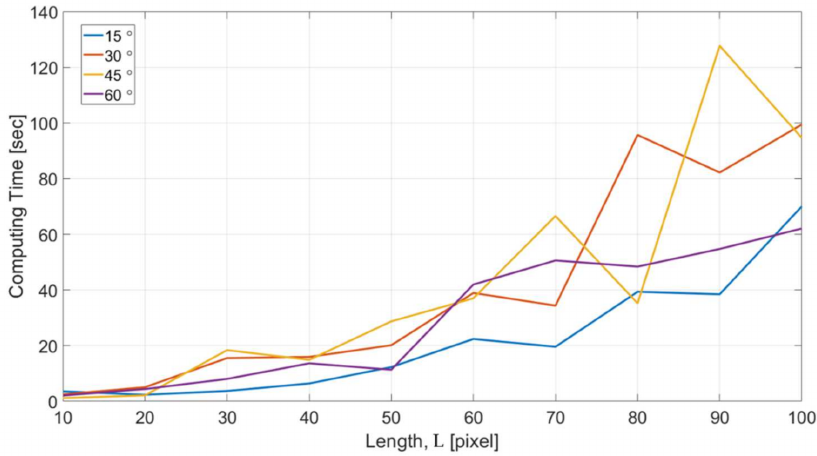
Figure 17. The computational cost with different feature